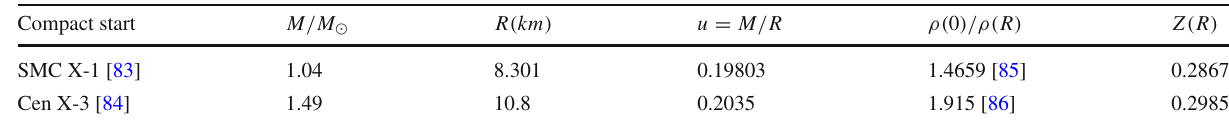
Table 1 Physical parameters for the compact starts SMC X-1 and Cen X-3